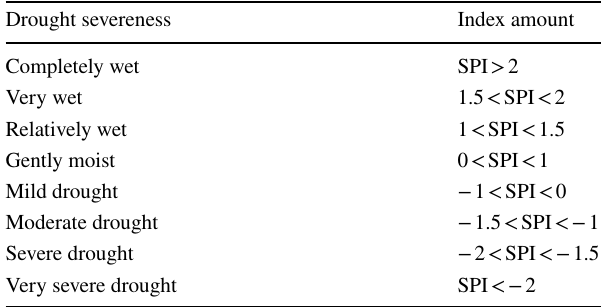
Table 2 Drought severity classification based on SPI values Drought severeness Index amount Completely wet SPI >